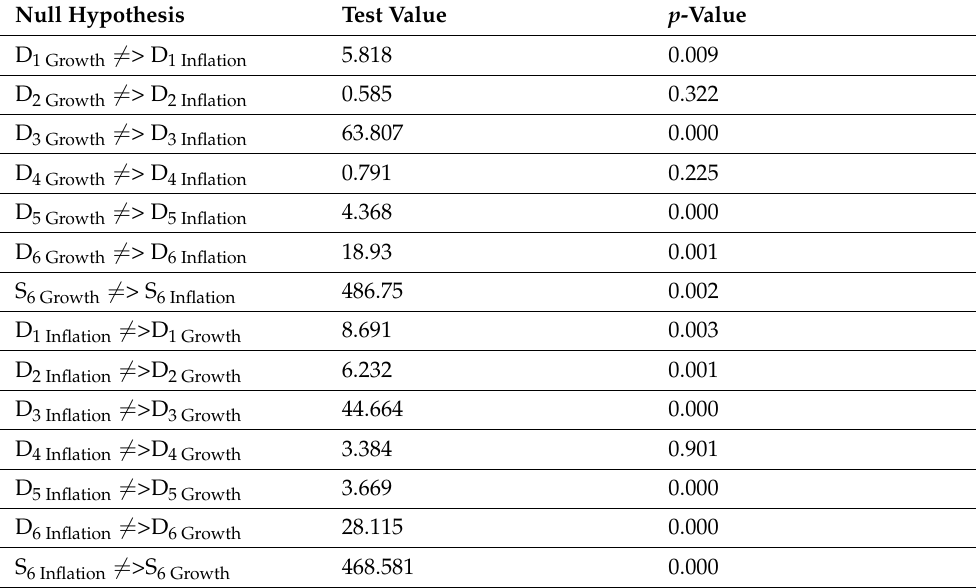
Table 6. Multi-scale Granger causality tests (growth and